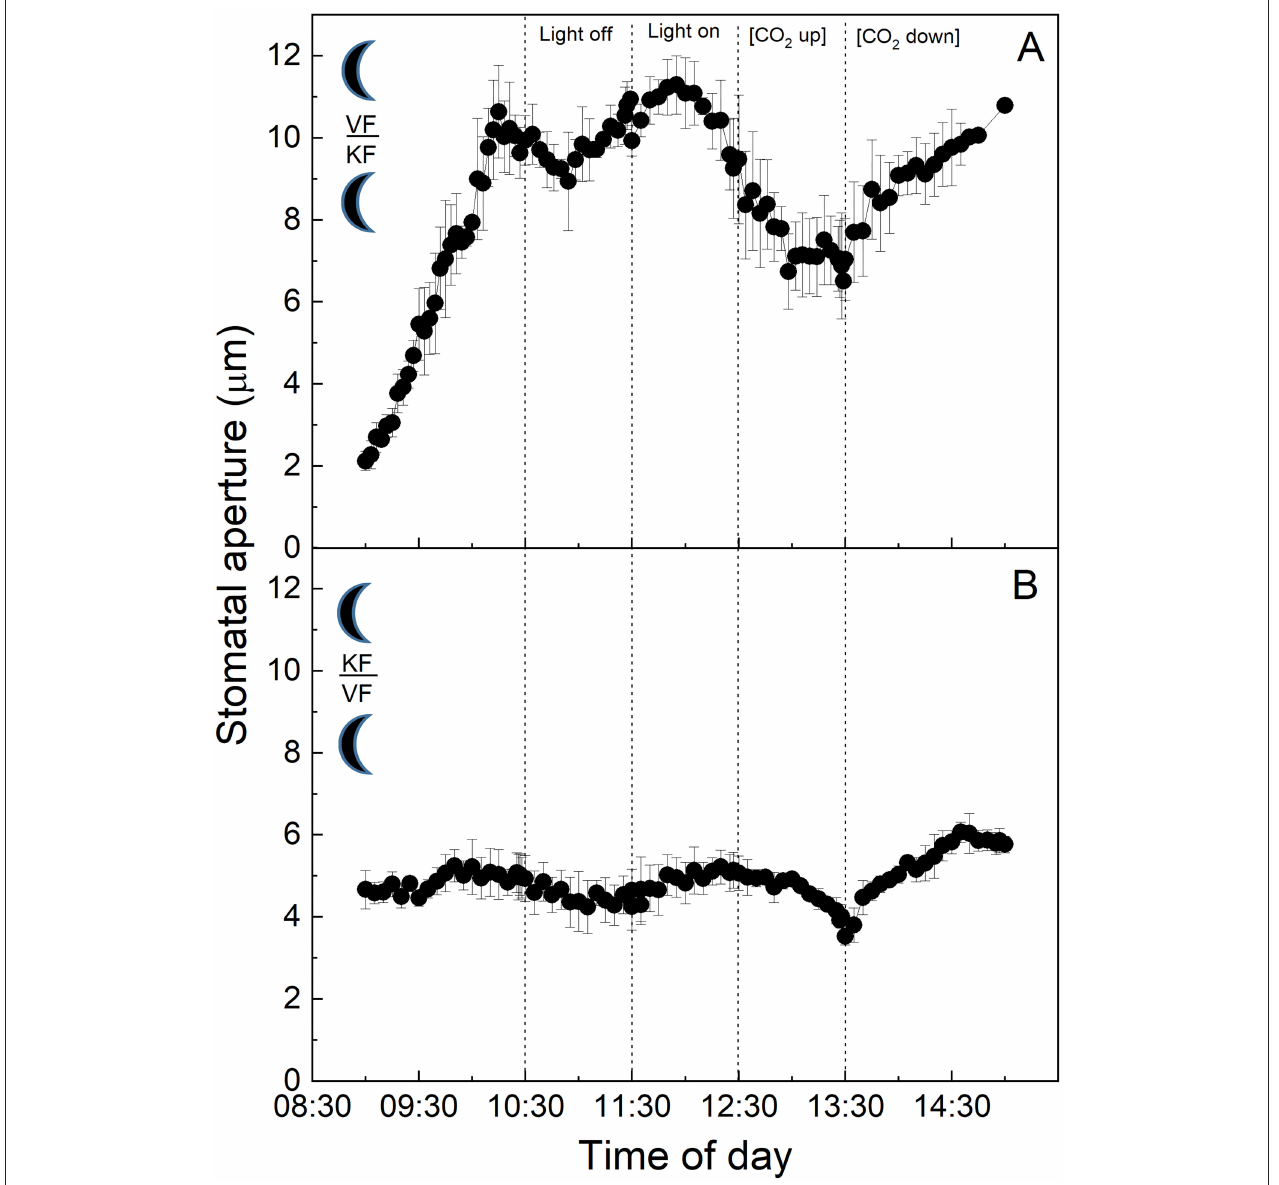
FIGURE 6 | (A) Abaxial peeled epidermis of Vicia faba leaf on abaxial exposed mesophyll of Kalanchoë fedschenkoi leaf both from the “dark” growth chamber; (B) Abaxial peeled epidermis of Kalanchoë fedschenkoi leaf on abaxial exposed mesophyll of Vicia faba leaf from the “dark” growth chamber (reverse light period 8:00 p.m. to 8:00a.m.). Light intensity was changed from photon flux density of 400 µ mol m − 2 s − 1 to darkness, as indicated, and [CO 2 ] was changed from 120 to 650 µ mol mol − 1 , as indicated. The temperature of the chamber was maintained at 23 ◦ C. The values are means of four repetitions ( ± SE). The moon symbol represents plants taken from the dark-grown